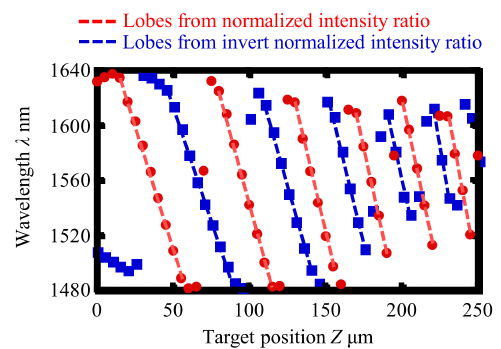
Figure 9. Wavelength-to-displacement encoding curves obtained from the axial responses of the normalized intensity ratio and that of the invert normalized intensity ratio, with target positions ranging from 0 to 250 µ m and a defocus d of 110 µ